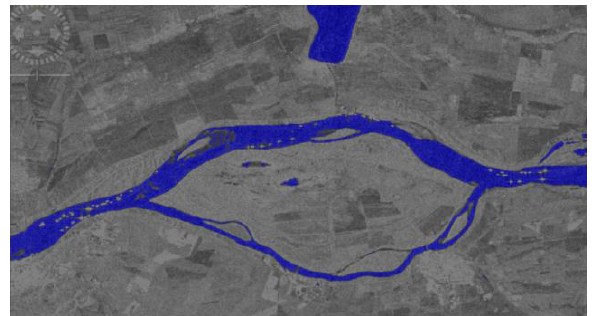
Figure 11. Water mask Zimnicea – 09.08.2015 -